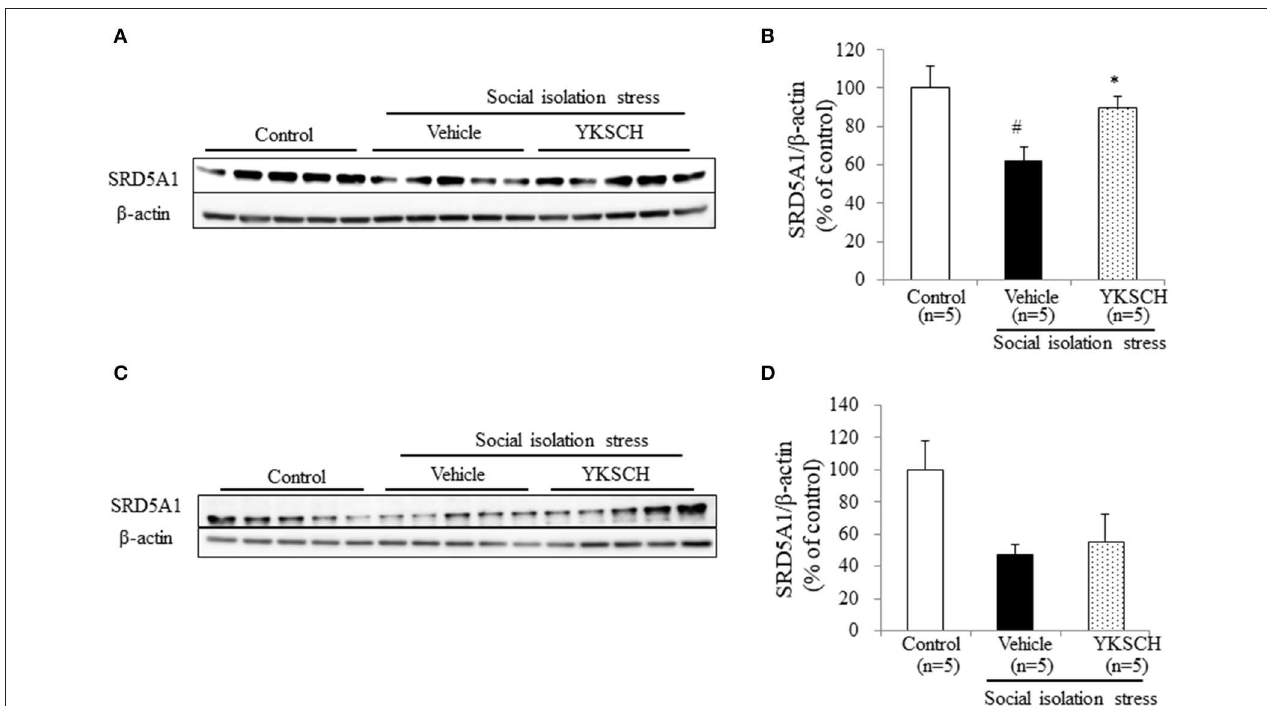
FIGURE 7 | Effect of YKSCH on SRD5A1 expression in the olfactory bulb and prefrontal cortex. (A,B) Western blot analyses of SRD5A1 expression in the OB. (A) Representative images of immunoblots obtained using antibodies against SRD5A1 and β -actin. (B) Quantitative analyses of OB SRD5A1 in socially isolated mice. (C,D) Western blot analyses of SRD5A1 expression in the PFC. (C) Representative images of immunoblots obtained using antibodies against SRD5A1 and β -actin. (D) Quantitative analyses of PFC SRD5A1 in socially isolated mice. Data are expressed as mean % of control ± SEM ( n = 5). # p < 0.05 vs. the control group; * p < 0.05 vs. the vehicle-treated group, Peritz’s F